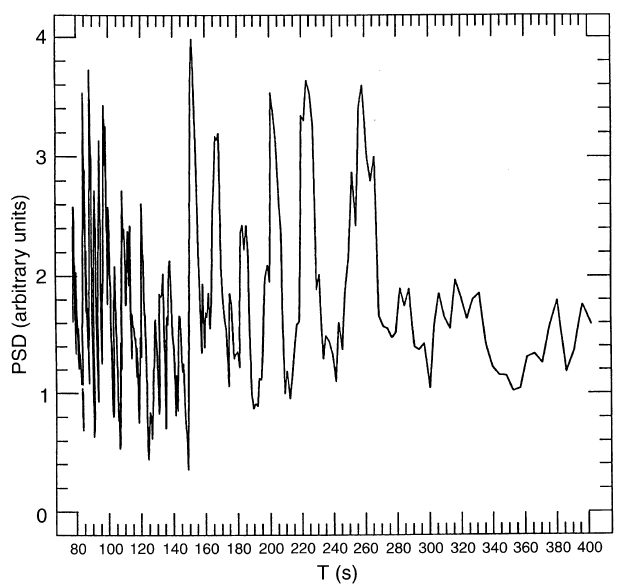
Fig. 4. The power spectrum density of Lomnicky Stit neutron monitor count rate registered on 20